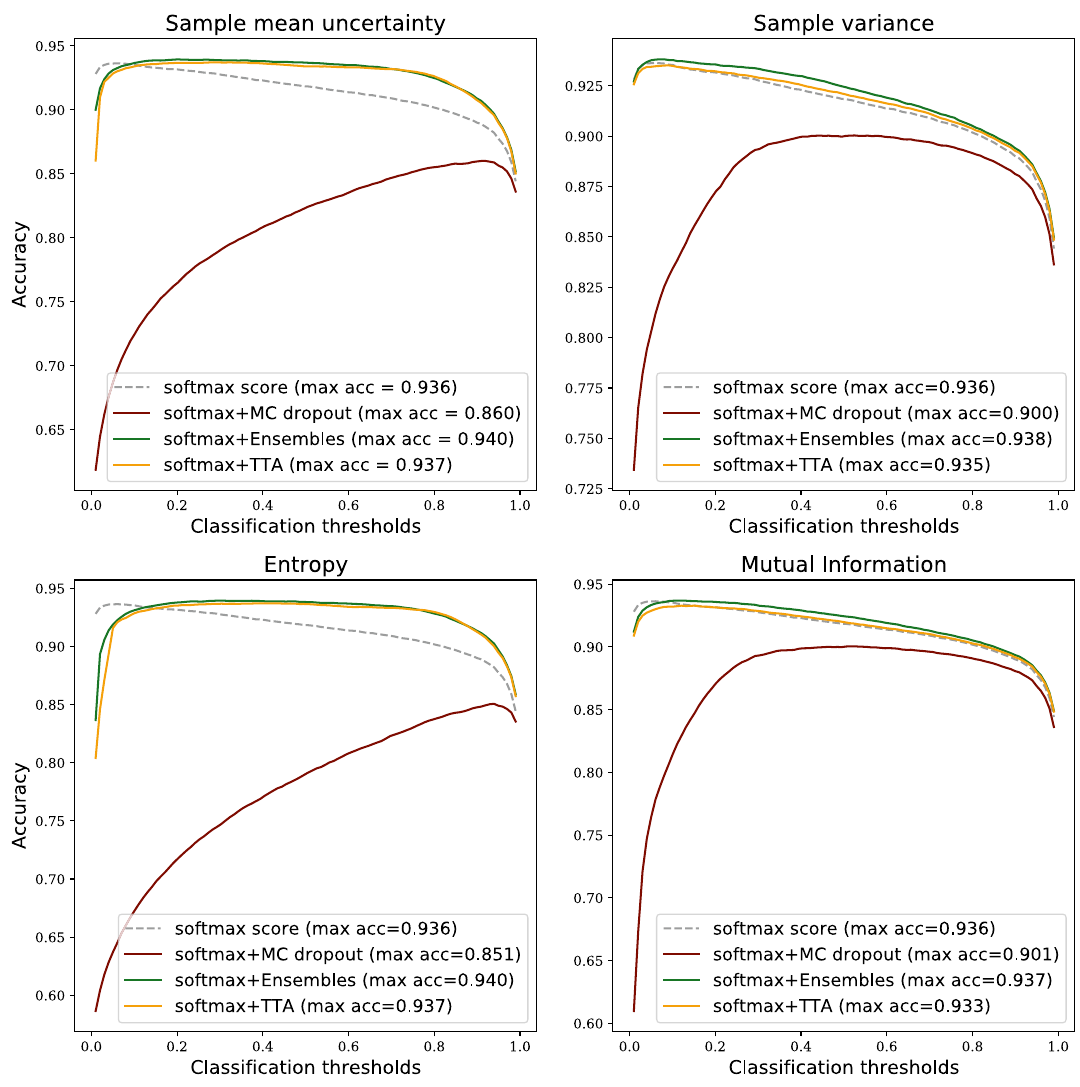
Figure 5. Prediction accuracy on BRLN data when combining softmax tumour score from a single NN with uncertainty